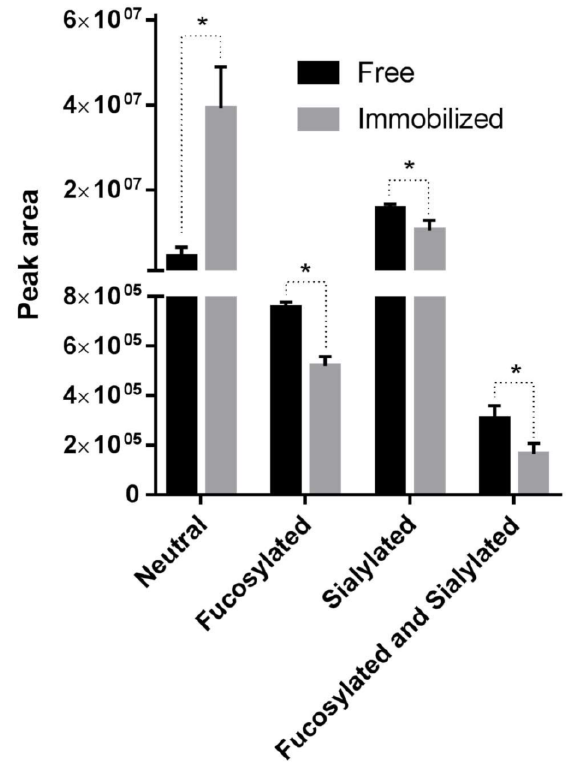
Figure 7. Mean relative quantities of various classes of released N -glycans from bovine colostrum whey proteins determined by nano-LC Chip Q-ToF MS/MS by free and immobilized Endo BI-1. Error bars represent one standard deviation. * Represents significant differences within the same class of N -glycans at p < 0.05.